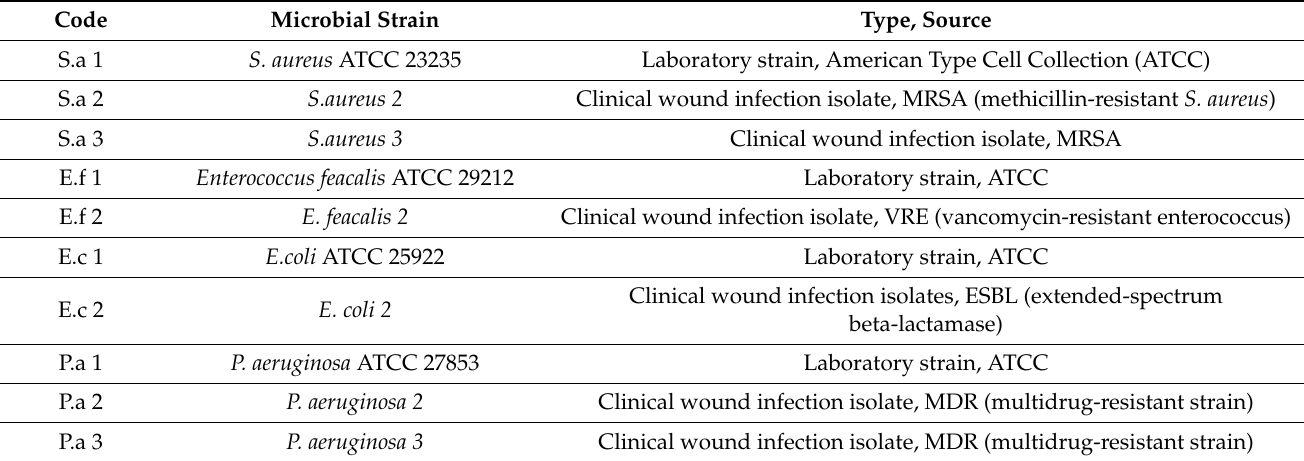
Table 1. Codes, source, and type of microbial strains utilized in this